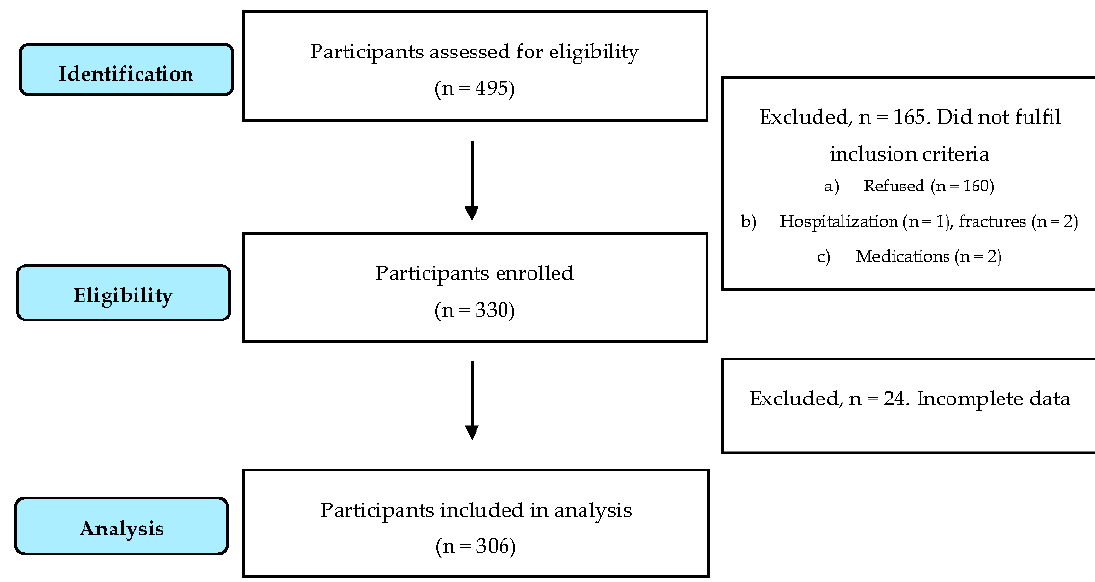
Figure 1. Flow diagram for study participants.